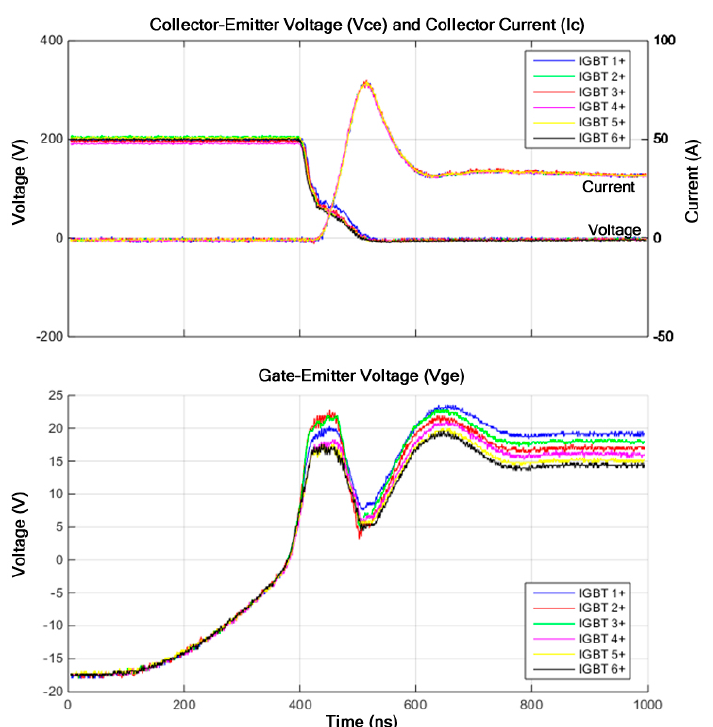
Figure 16. Turn-on switching with 30 A load current, evidencing an increase in the effects of the natural intrinsic balance with the increase of the collector current, imposing an optimal voltage sharing among the devices.